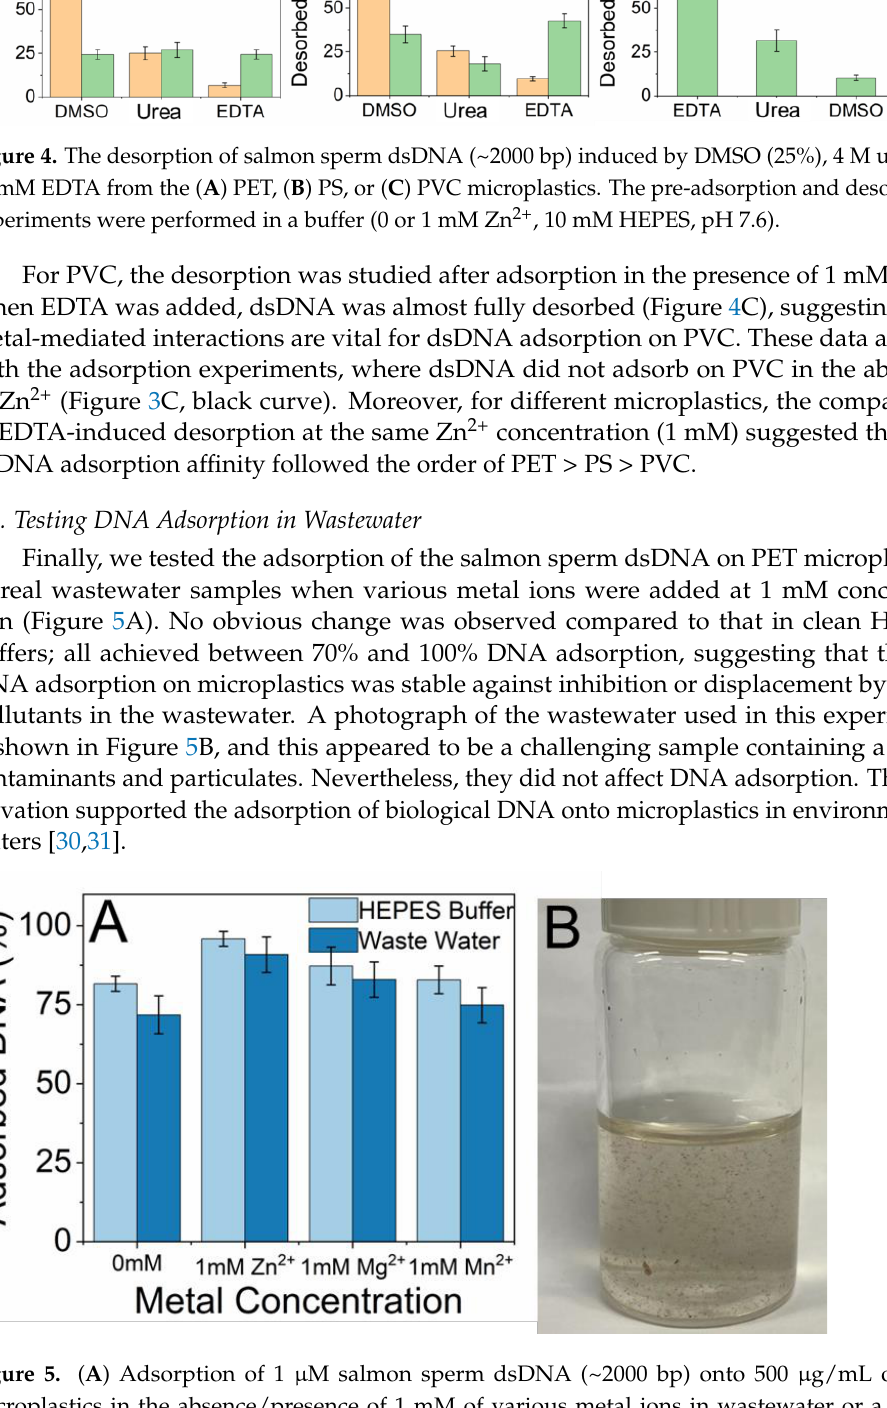
7 Figure 4. The desorption of salmon sperm dsDNA (~2000 bp) induced by DMSO (25%), 4 M urea, or 10 mM EDTA from the ( A ) PET, ( B ) PS, or ( C ) PVC microplastics. The pre-adsorption and de- sorption experiments were performed in a buffer (0 or 1 mM Zn 2+ , 10 mM HEPES, pH 7.6). When DNA was adsorbed in the presence of 1 mM Zn 2+ , the desorption induced by